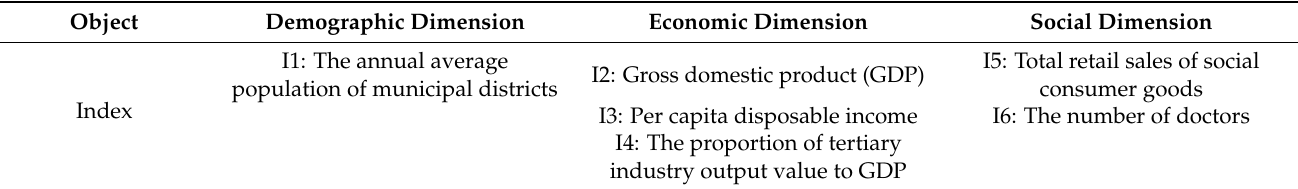
Table 1. Index system of urban